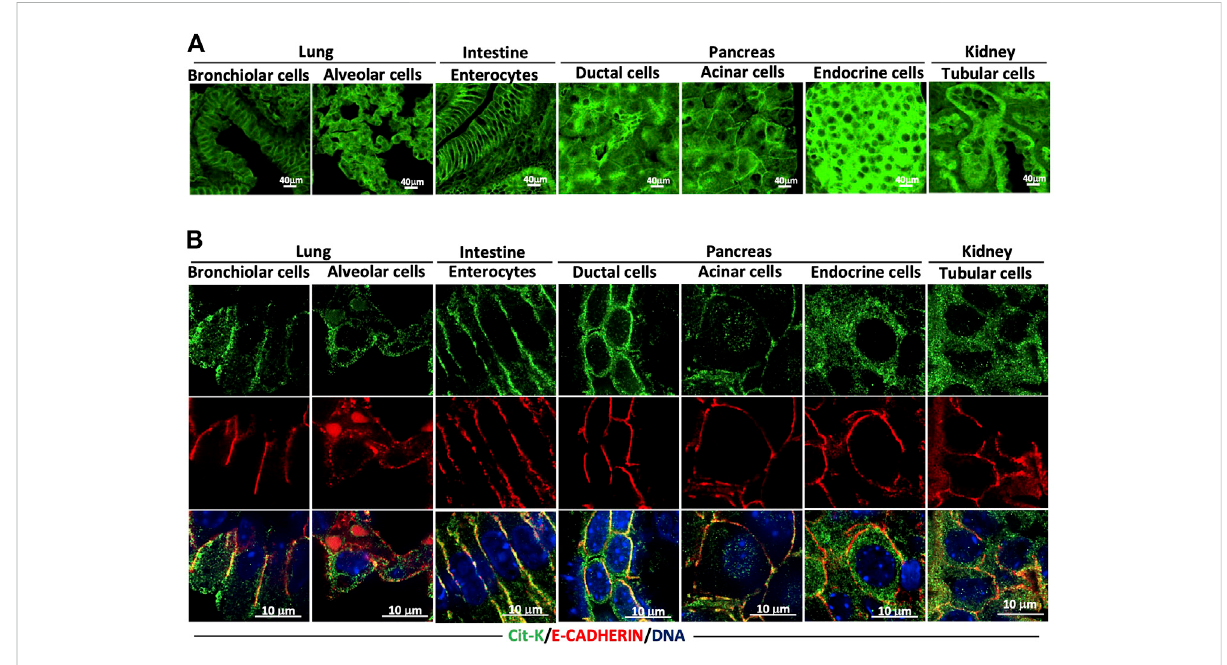
The cellular localization of KRAS varies according to the cell type. (A) Immunolabelling performed on lung, intestine, pancreas, and kidney sections of 8-week-old Kras cit/cit mice for Cit-K. (B) Confocal images of Cit-K and E-CADHERIN (E-CAD; used as a cell membrane marker) immunolabelling performed on lung, intestine, pancreas, and kidney sections of 8-week-old Kras cit/cit mice. DAPI was used to visualize cell